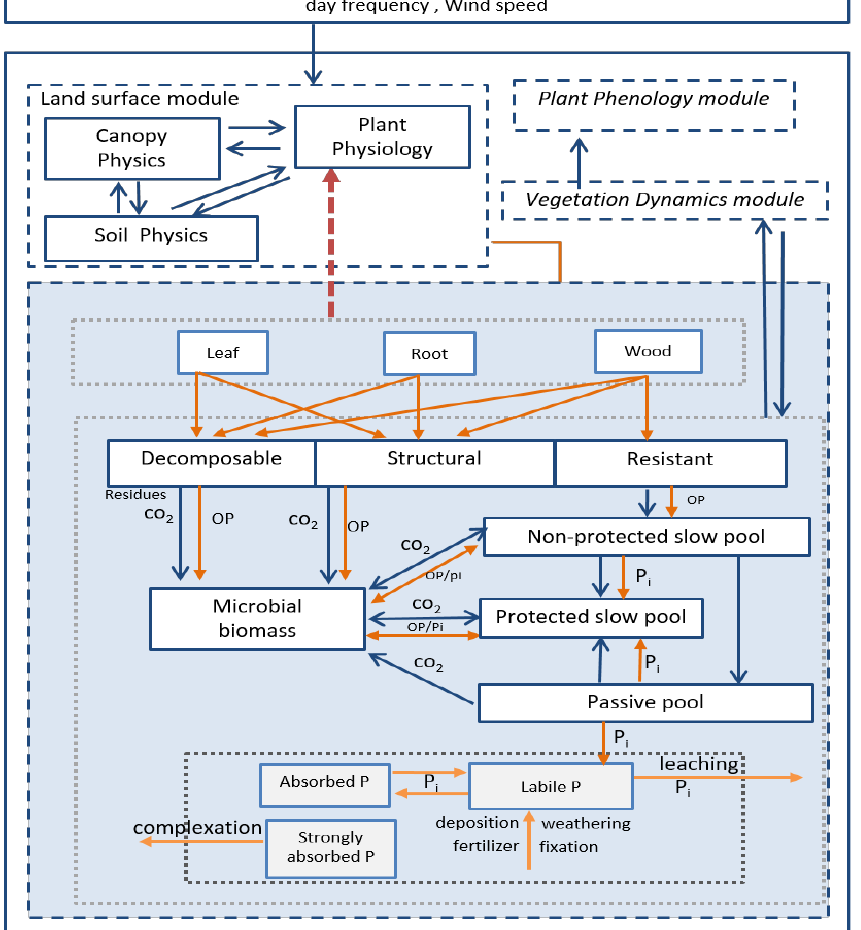
Figure 1. Schematic representation of modules, pools and fluxes in TRIPLEX-CNP. The dashed boxes indicate main modules (plant phenology, vegetation dynamics, land surface and soil biogeochemistry). The solid boxes indicate pools of carbon, nitrogen or phosphorus. The arrows indicate fluxes of phosphorus (orange) and of carbon or nitrogen (blue). The red dotted arrow indicates feedback from phosphorus to photosynthesis.